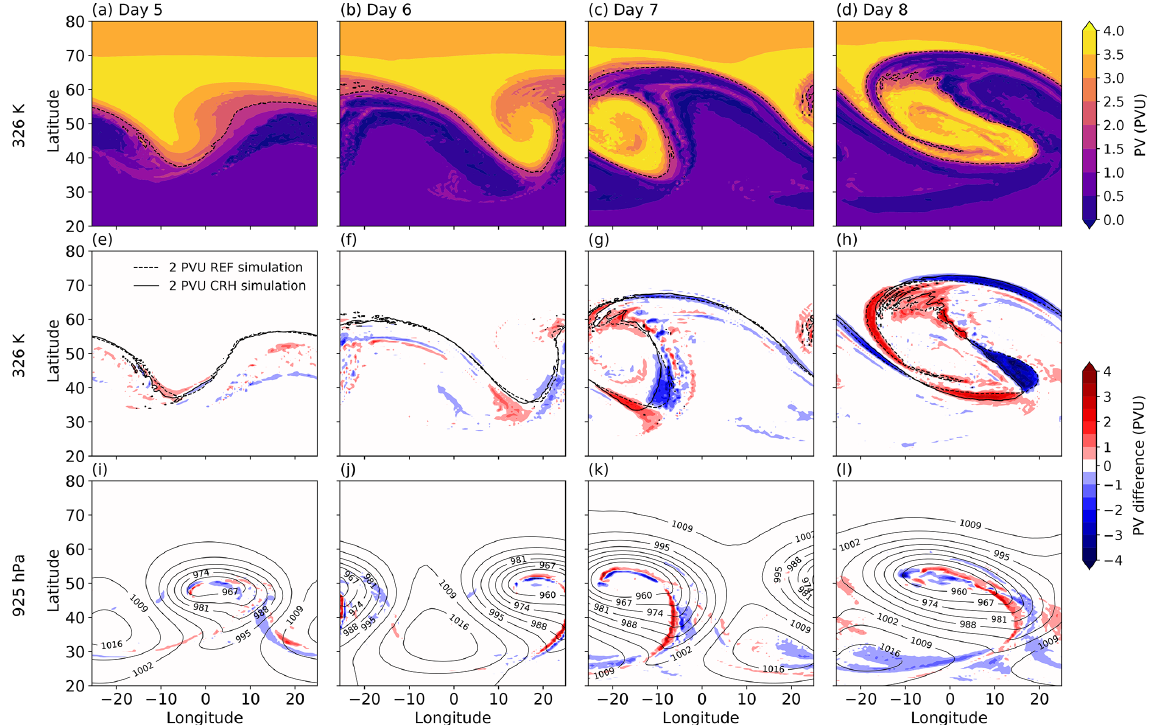
Figure 5. Upper-level PV evolution on the 326K isentrope for the REF simulation from days 5 to 8 (a–d) . PV differences between the CRH and REF simulations (CRH–REF) at upper levels on the 326K isentrope (e–h) and at lower levels on the 925 hPa isobaric surface (i–l) . The dynamical tropopause is shown in solid and dashed black lines for CRH and REF simulations, respectively. The thin black contours depict the surface pressure (hPa) averaged between the two